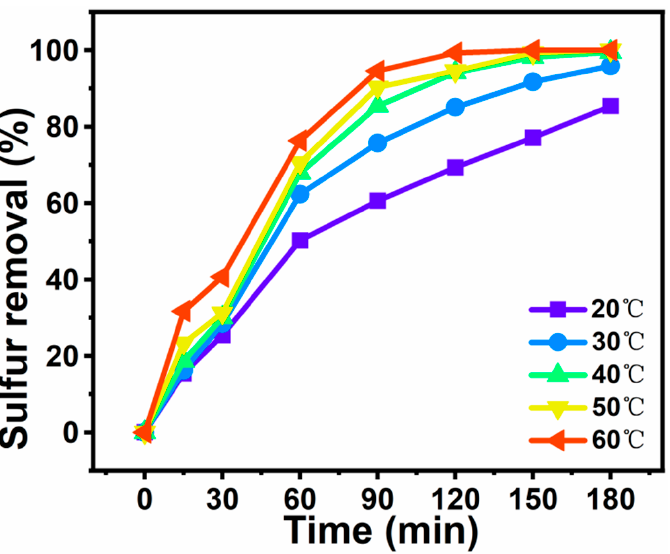
Figure 10. Effects of temperature on sulfur removal efficiency of DBT. Experimental conditions: V DBT = 5 mL, V IL = 3 mL, O/S = 6, m([BMIM] 3 PMo 12 O 40 -based MCF) = 30 mg, and t = 3 h.